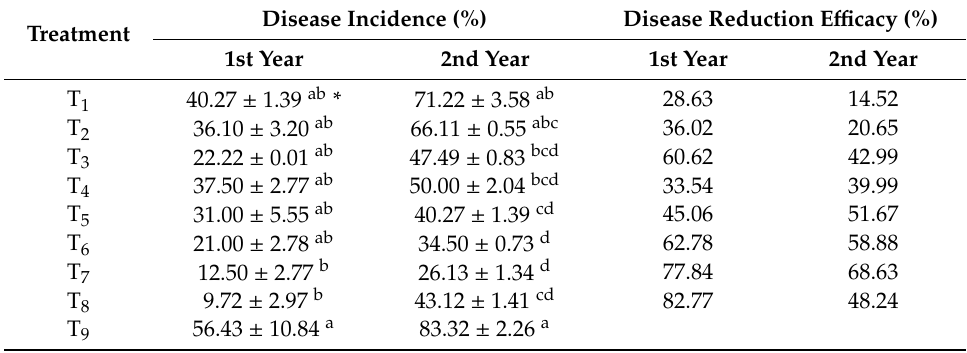
Table 1. Field experiment of percentage incidence of corm rot of sa ff ron in di ff erent treatments during 2017 and 2018. T 1 = Bacillus stratosphericus at 1 × 10 9 cfu / mL; T 2 = B. pumilus at 1 × 10 9 cfu / mL; T 3 = B. subtilis at 1 × 10 9 cfu / mL; T 4 = Pseudomonas aeruginosa at 1 × 10 9 cfu / mL; T 5 = P. putida at 1 × 10 9 cfu / mL; T 6 = P. fluorescens at 1 × 10 9 cfu / mL; T 7 = Trichoderma asperellum at 1 × 10 8 cfu / mL; T 8 = carbendazim 50 WP at 0.2%; and T 9 = water (control). ± is the standard error of the mean of disease incidence. * Means followed by the same letter do not significantly di ff er ( p < 0.05) with DNMRT. Disease incidence = Total number of plants infected in selected treatment / total number of plants in selected treatment × 100. Disease reduction e ffi cacy = Disease incidence of control - disease incidence of treatment / disease incidence of control × 100. Disease Incidence (%) Disease Reduction E ffi cacy (%) Treatment 1st Year 2nd